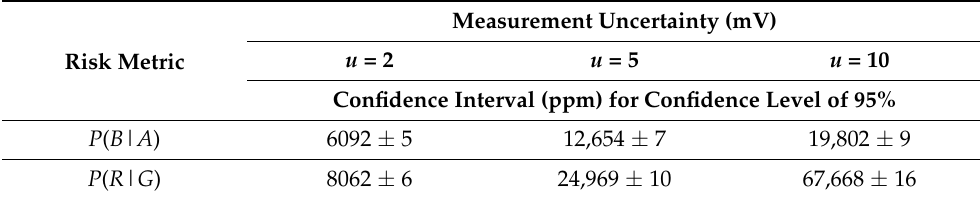
Table 5. The confidence intervals of the risk metrics reference